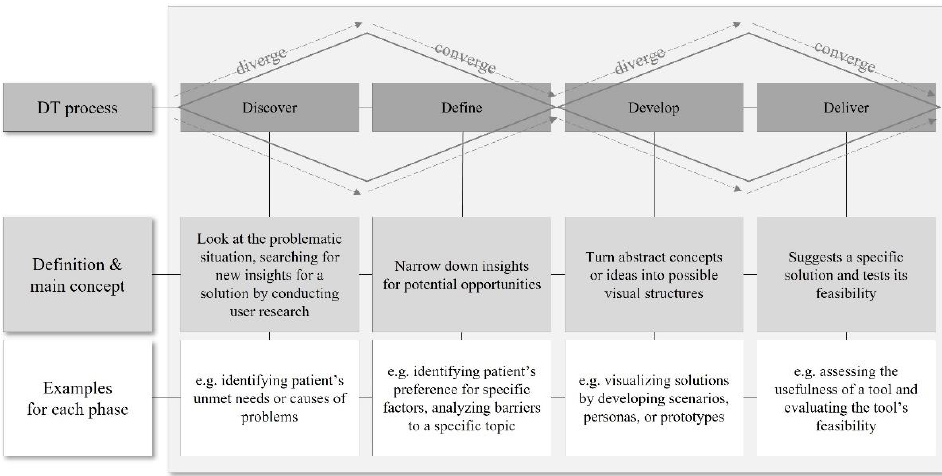
Figure 1. The DT process as a framework for creative problem-solving.